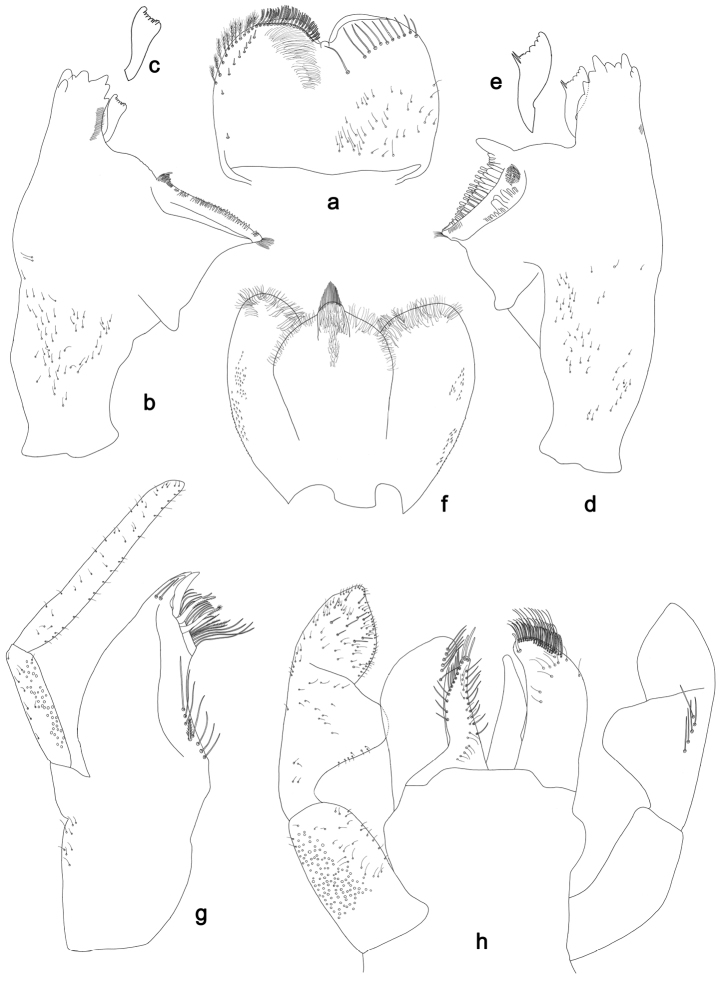
Labiobaetispindaundensis sp. n., larva morphology: a Labrum b Right mandible c Right prostheca d Left mandible e Left prostheca fHypopharynxg Maxilla h Labium.